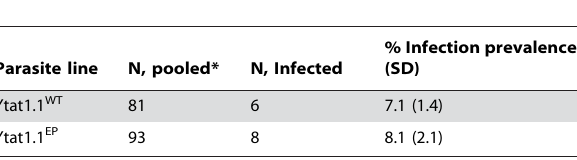
Table 1. Midgut infection prevalence in flies challenged with either YTat1.1 WT or YTat1.1 EP .